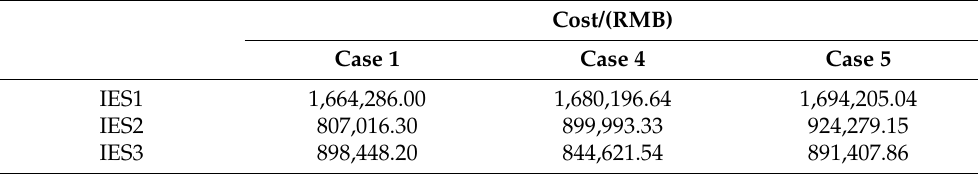
Table 17. Comparison of the results of Cases 1, 4, and 5.